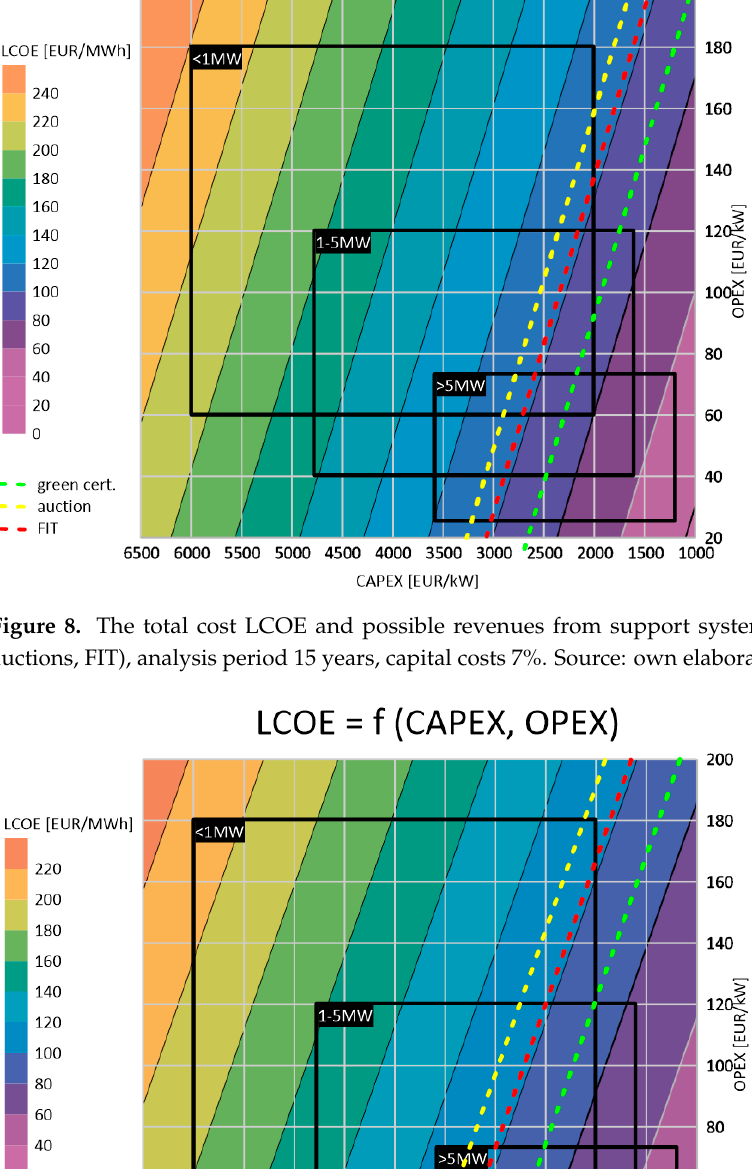
( b ) Figure 7. Examples of CAPEX and OPEX boundaries for SHP ensuring obtaining LCOE at the level of revenues that can be obtained ( a ) in the auction system, ( b ) in the FIT system. Source: own elab ‐ oration. Results presented in Figures 5–7 and discussed above show the total cost distributed